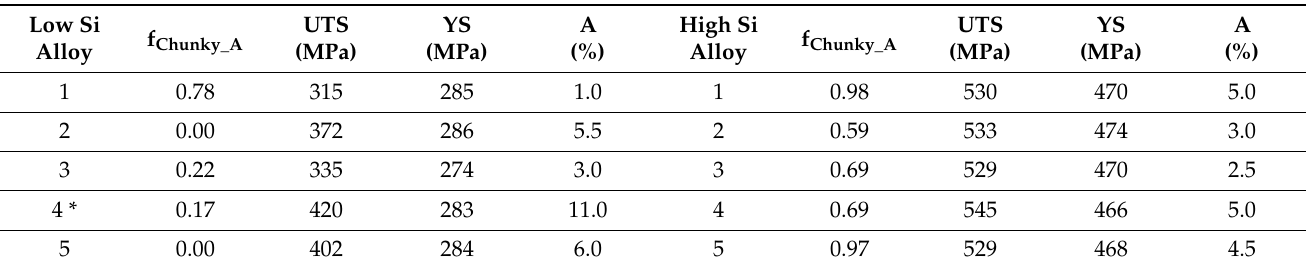
Table 5. Effect of chunky graphite content on the tensile properties of a low silicon (2.46 wt.%) alloy with about 25% of pearlite and of a fully ferritic high silicon (4.17 w.%) ductile iron alloy, both free of spiky graphite